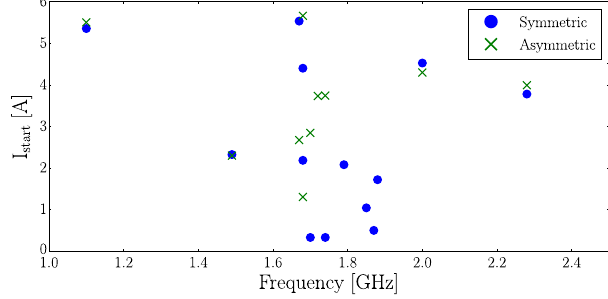
FIG. 14. Comparison of the start currents for symmetric and asymmetric cavities is shown using T